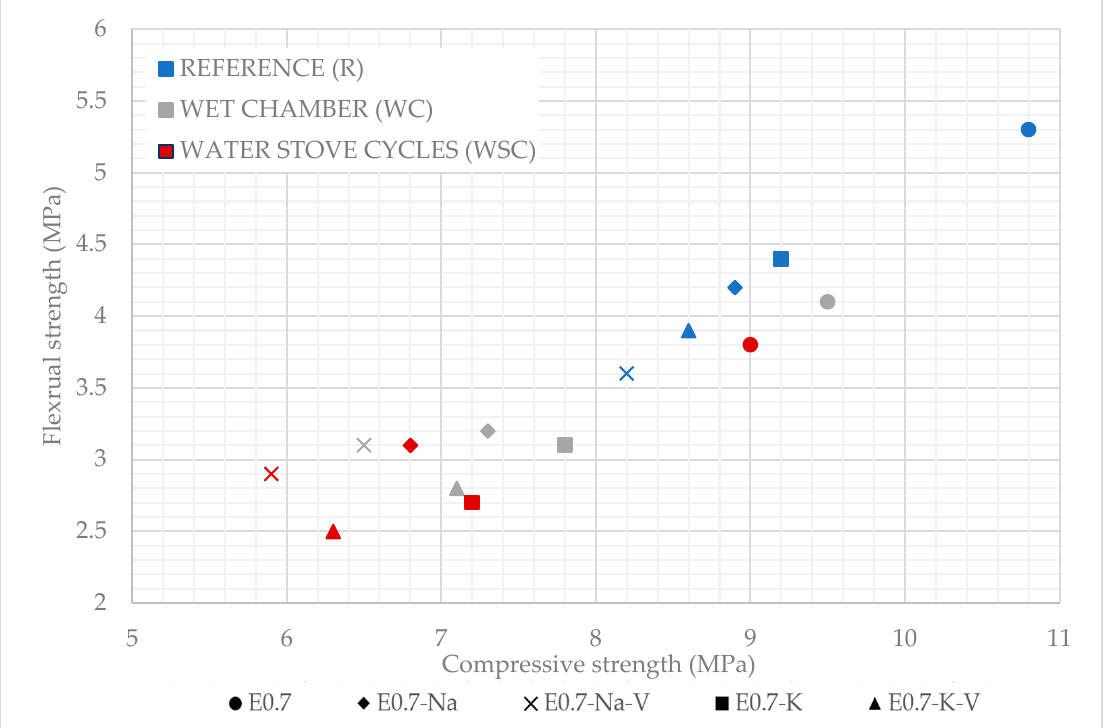
Figure 9. All mechanical performance results.